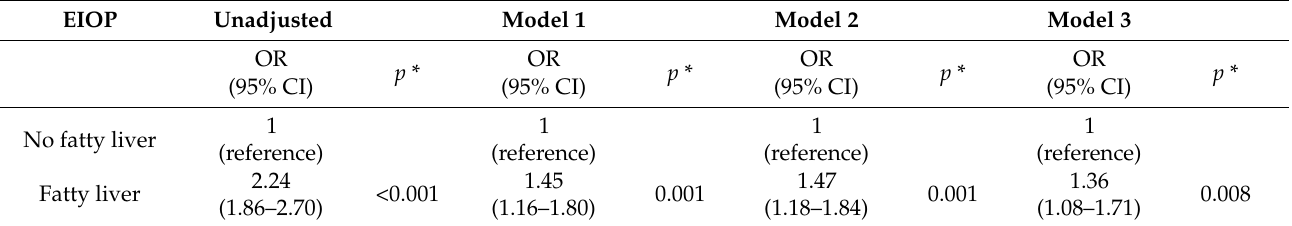
Table 2. Logistic regression analysis to estimate the risk of elevated intraocular pressure according to fatty liver status.